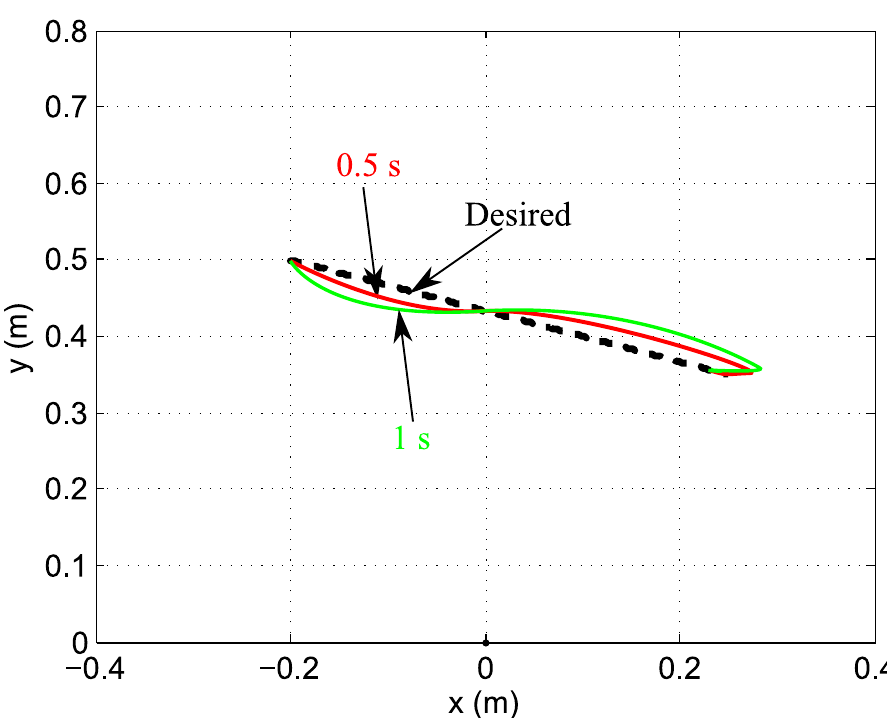
Fig 8. Simulated movement of a 2-joint planar arm with a duration of 0.5 s and 1 s. A linear movement with a duration between 0.5 s and 0.75 s using the shoulder and elbow joints is reproduced by the proposed control. A faster movement involves larger interaction forces. A comparable deviation is produced by the proposed control for both fast and slow movements, indicating that the proposed control successfully compensates for the interaction forces between the two